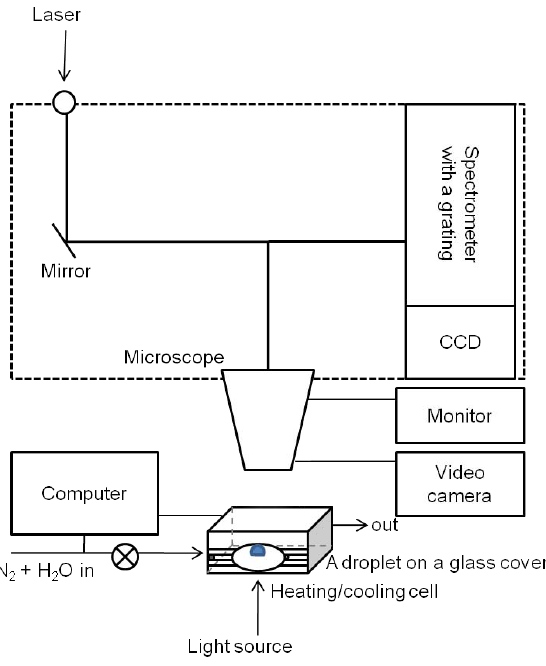
Fig. 1. Schematic representation of the experimental setup. A single particle (shown as blue half sphere) is deposited on a hydrophobi- cally coated slide